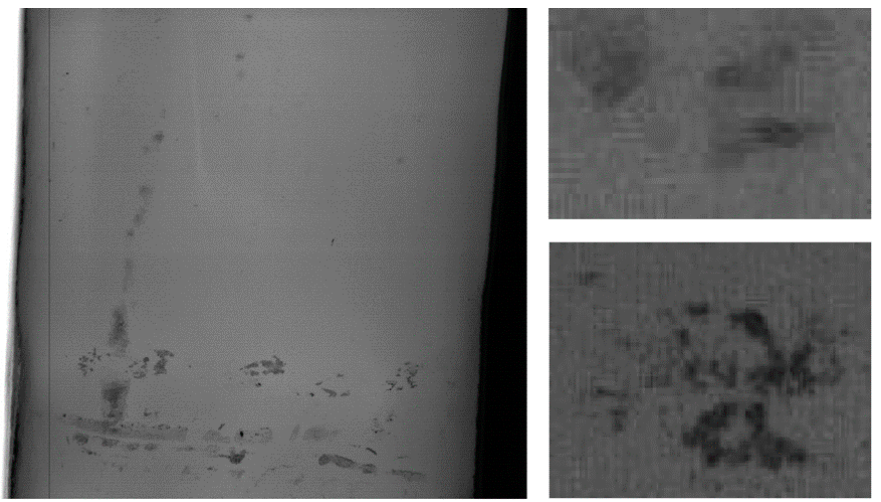
Figure 6. Examples of grease stains in the bottle.